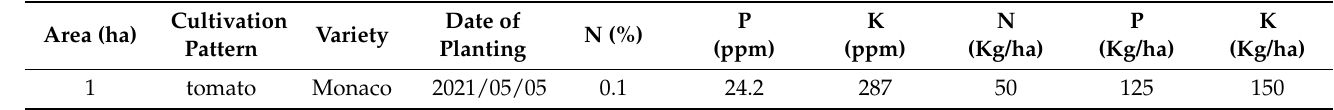
Table 2. Soil testing and crop calendar.